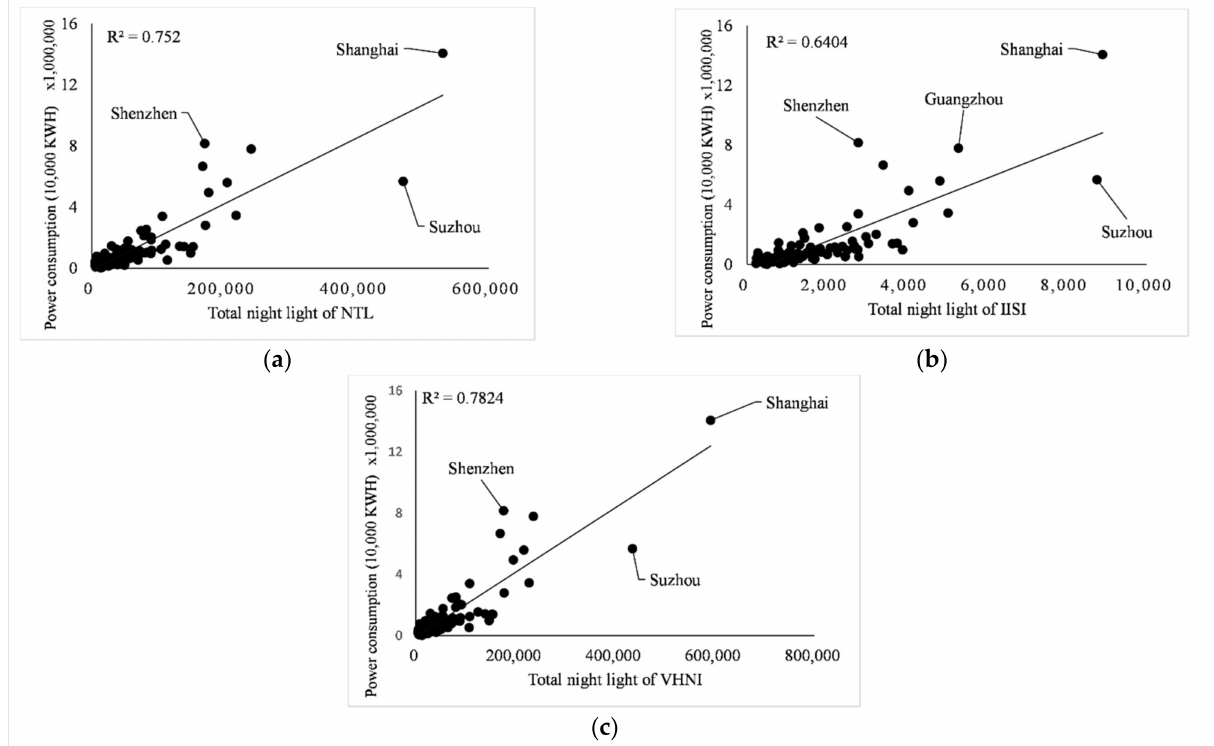
Figure 8. ( a – c ) Fitting relationships between NTL , IISI , VHNI and power consumption, respectively. It can be seen from Table 3 that in the regression analysis of the three indicators of all municipal administrative regions, in the regression analysis of GDP, population and